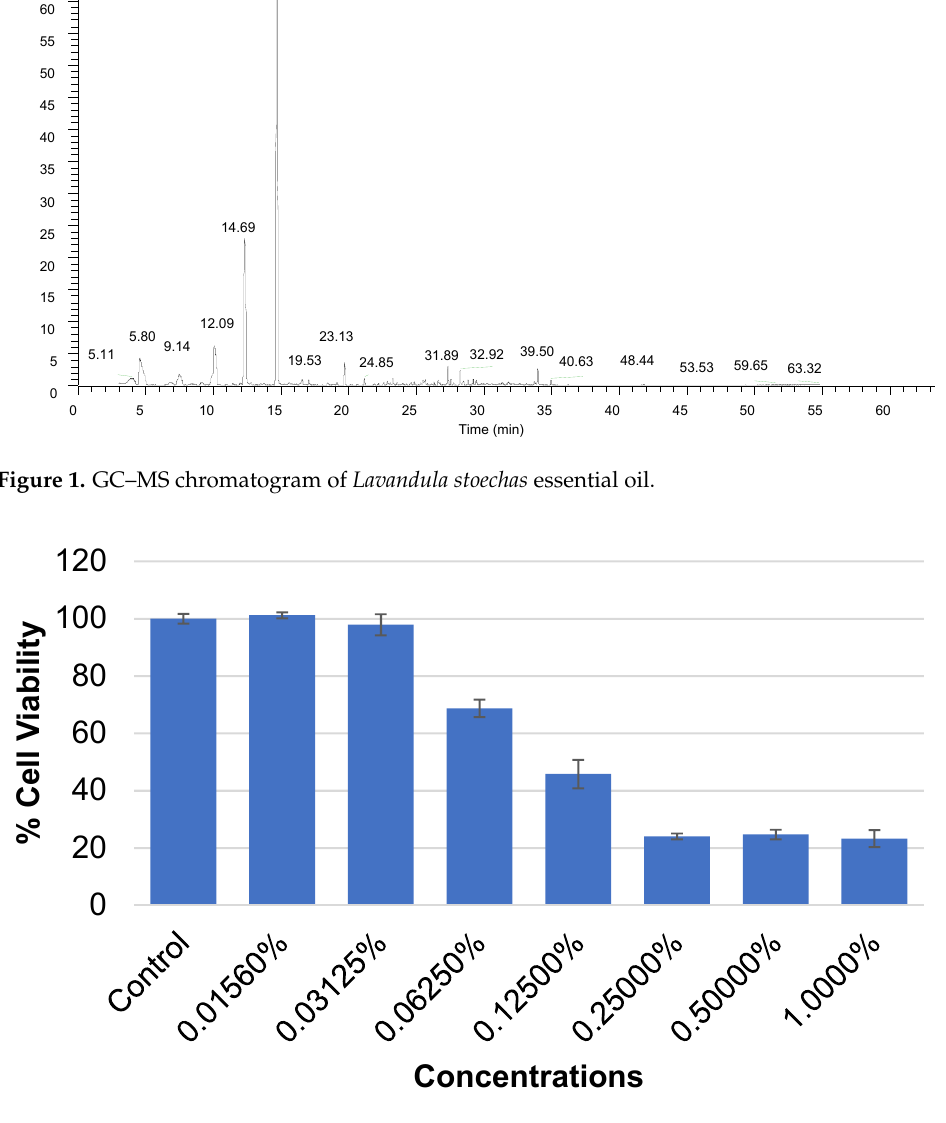
Figure 2. Cytotoxic activity of lavender oil against HEK-293 cells determined by MTT assay. Cells were exposed to different concentrations of the oil for 24 h. All values are presented as mean ± SD.